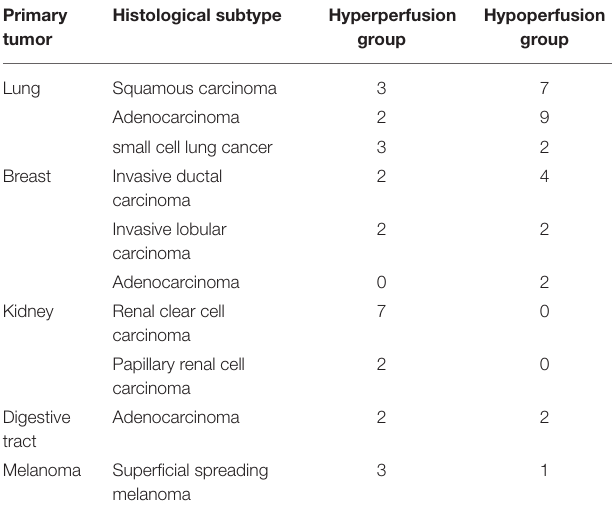
TABLE 2 | The detailed results of comparisons between two